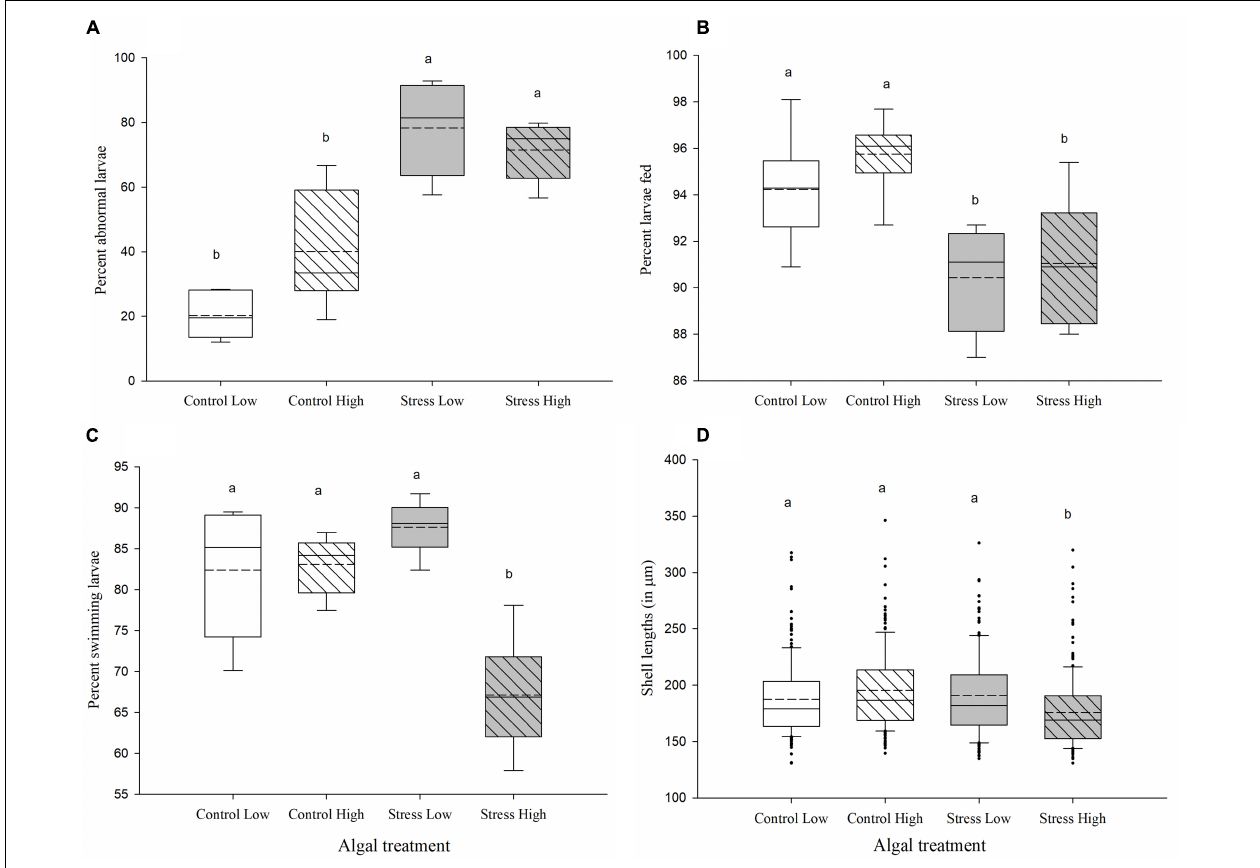
FIGURE 3 | Measurements of larval performance in Crassostrea gigas exposed to control and stressed algal cultures for 96 h. Percentages of (A) larval abnormalities, (B) feeding larvae, (C) actively swimming larvae, and (D) shell lengths of larvae (in µ m) were evaluated following 96 h of exposure to control/unstressed algae (white), and stressed algae (gray). Low ration (plain box) consisted of 25 cells µ L − 1 of a bispecific diet of C. calcitrans (CC) and T. lutea (T-Iso), while high ration (hashed box) consisted of 100 cells µ L − 1 of CC and T-Iso. A total of 100 larvae were assessed for abnormality and 30 larvae for feeding and swimming response from each tank. Box plots represent the distribution of the fitness parameters, in percent, between the sixtanks (A–C) or the shell sizes of n = 180 larvae (D) , per algal treatment. Median and mean (dashed line) values and the lower (25%) and upper (75%) quartiles are presented, while whiskers indicate the minimum and maximum values, and individual points are outliers ( D only). Treatments with the same letter were not significantly different ( p > 0.05; ANOVA, Tukey posthoc test).